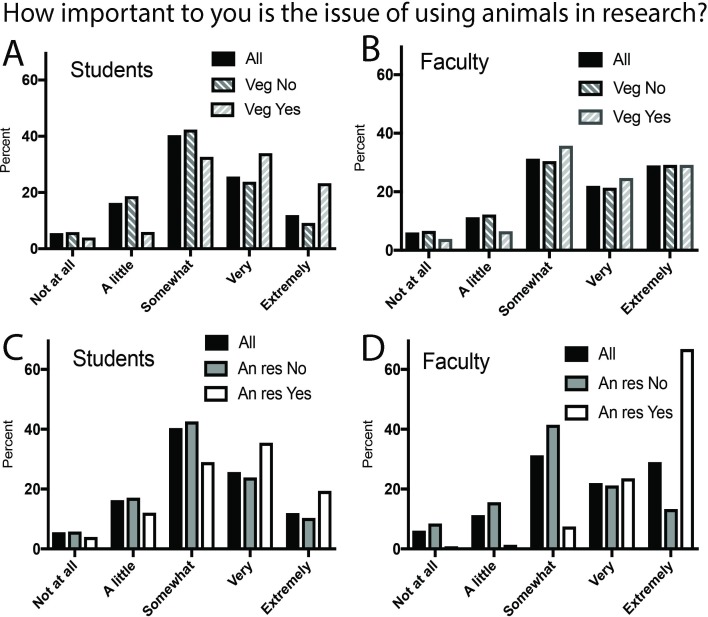
Dietary and animal research experience influences on importance of animal research.(A) Students and diet. (B) Faculty and diet. (C) Students and animal research experience. (D) Faculty and animal research experience.